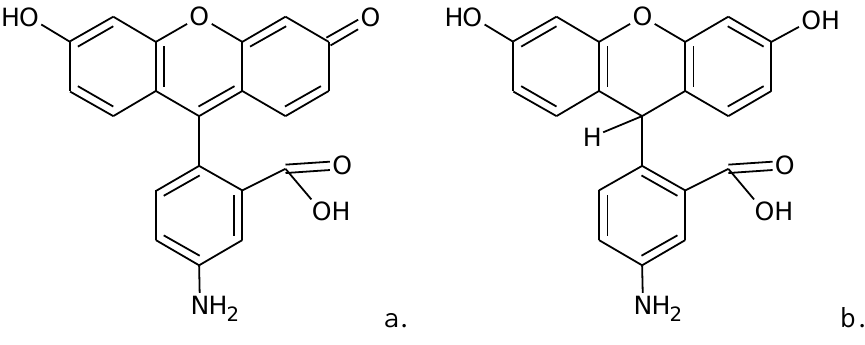
Figure 1. Chemical structures of fluoresceinamine (a) and probable reduced fluoresceinamine (b). OOH